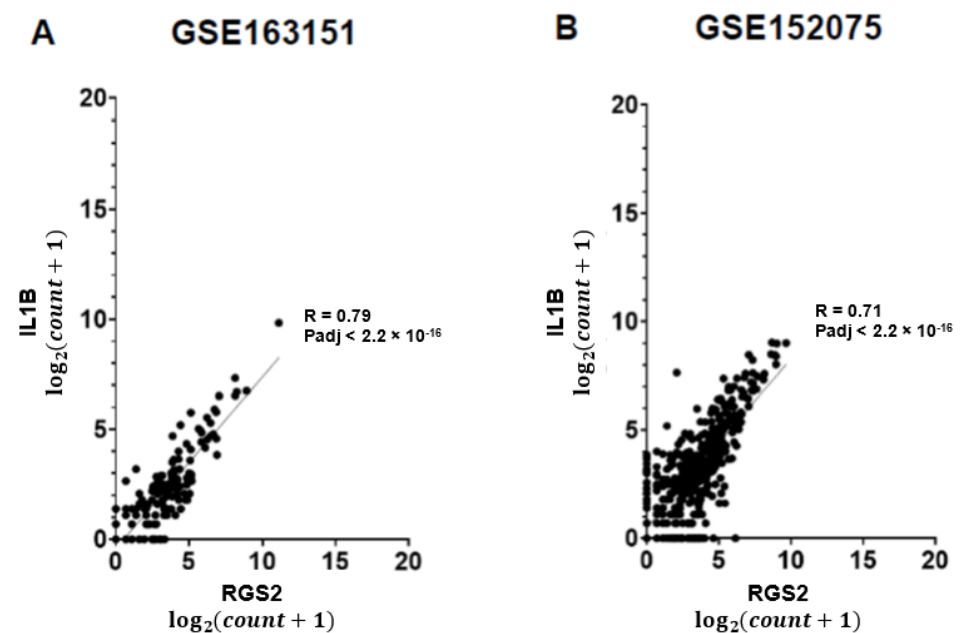
Figure 5. Positive correlation between expression levels of RGS2 and ILB1 from RNA-sequencing of nasopharyngeal swabs. Spearman correlations are shown for ( A ) dataset GSE163151; ( B ) dataset GSE152075. The set of genes most correlated with RGS2 expression ( p < 2 × 10 − 16 ; Table 1) was significantly enriched for cellular response to interleukin-8, neutrophil aggregation and G